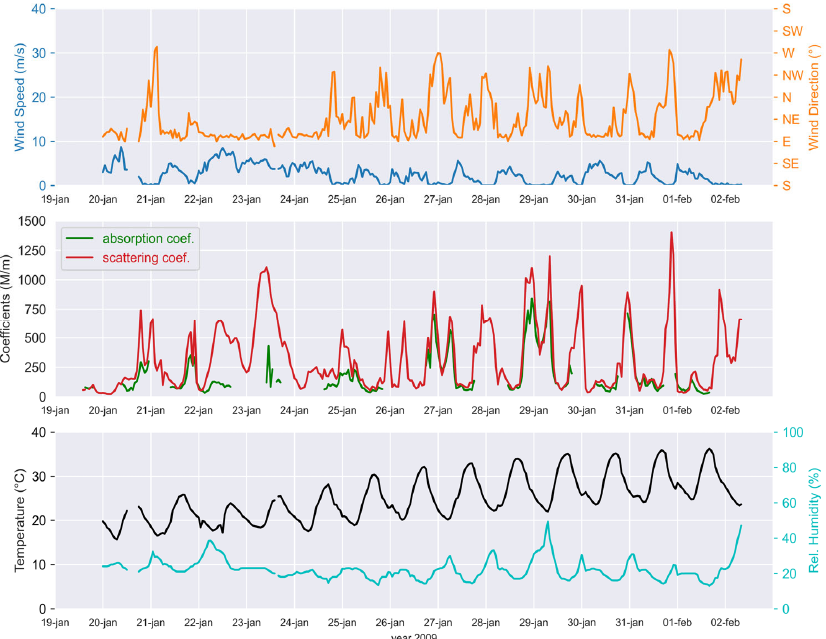
Figure 2. Light sca tt ering and absorption coe ffi cients, as well as meteorological data collected